Question: Identify the chart type used in this figure.
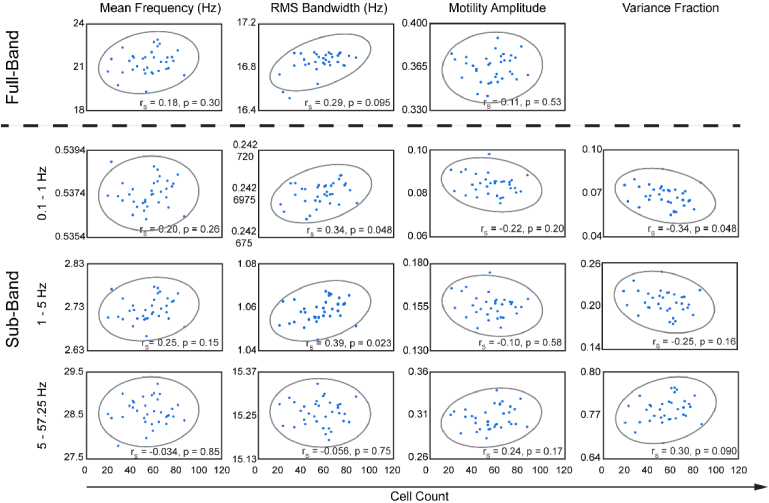
Answer: scatter